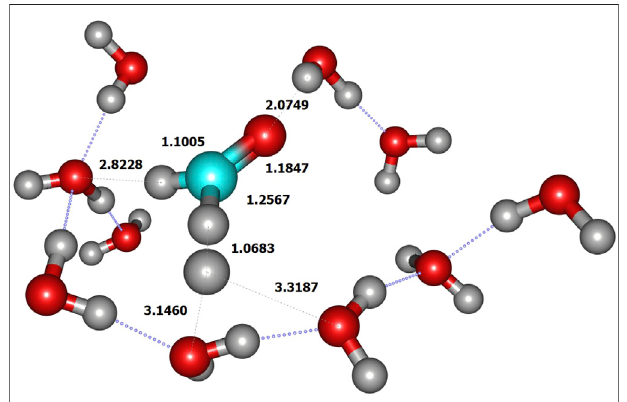
FIGURE 3 | TS geometry (limited to QM zone).